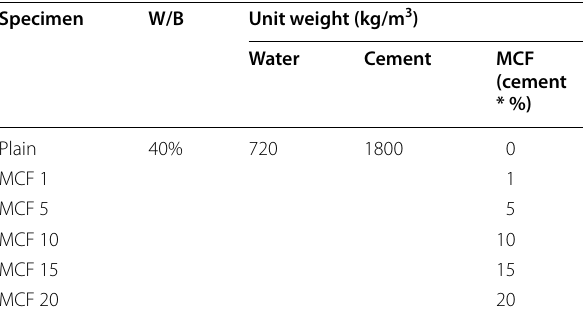
Table 2 Mixing design of cement paste.